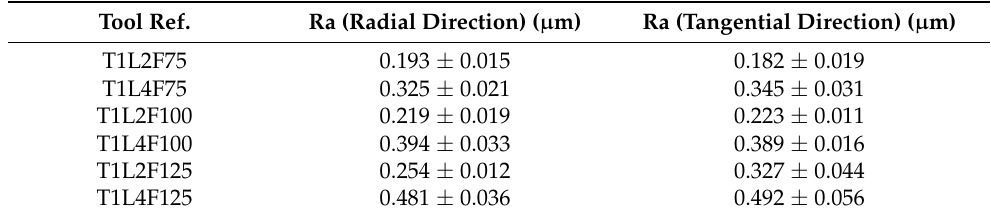
Table 8. Average surface roughness values, measured in the radial and tangential directions for the tests conducted with T1.